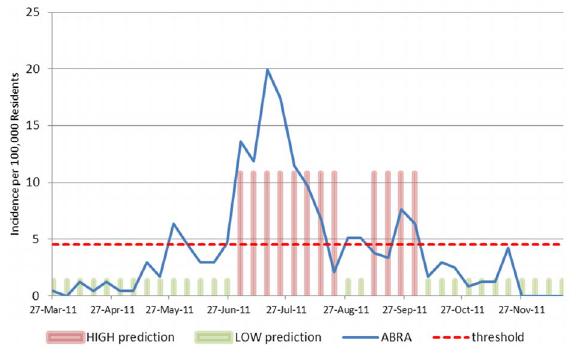
Figure 5. Incidence rate and predicted incidence rate for the province of Abra. Green bars correspond to prediction of LOW and red bars correspond to prediction of HIGH. When the incidence rate exceeds the threshold and a red bar is present, this corresponds to a TP; when the incidence rate is below the threshold and a green bar is present, this corresponds to a TN; when the incidence rate is above the threshold and a green bar is present, this corresponds to a FN.